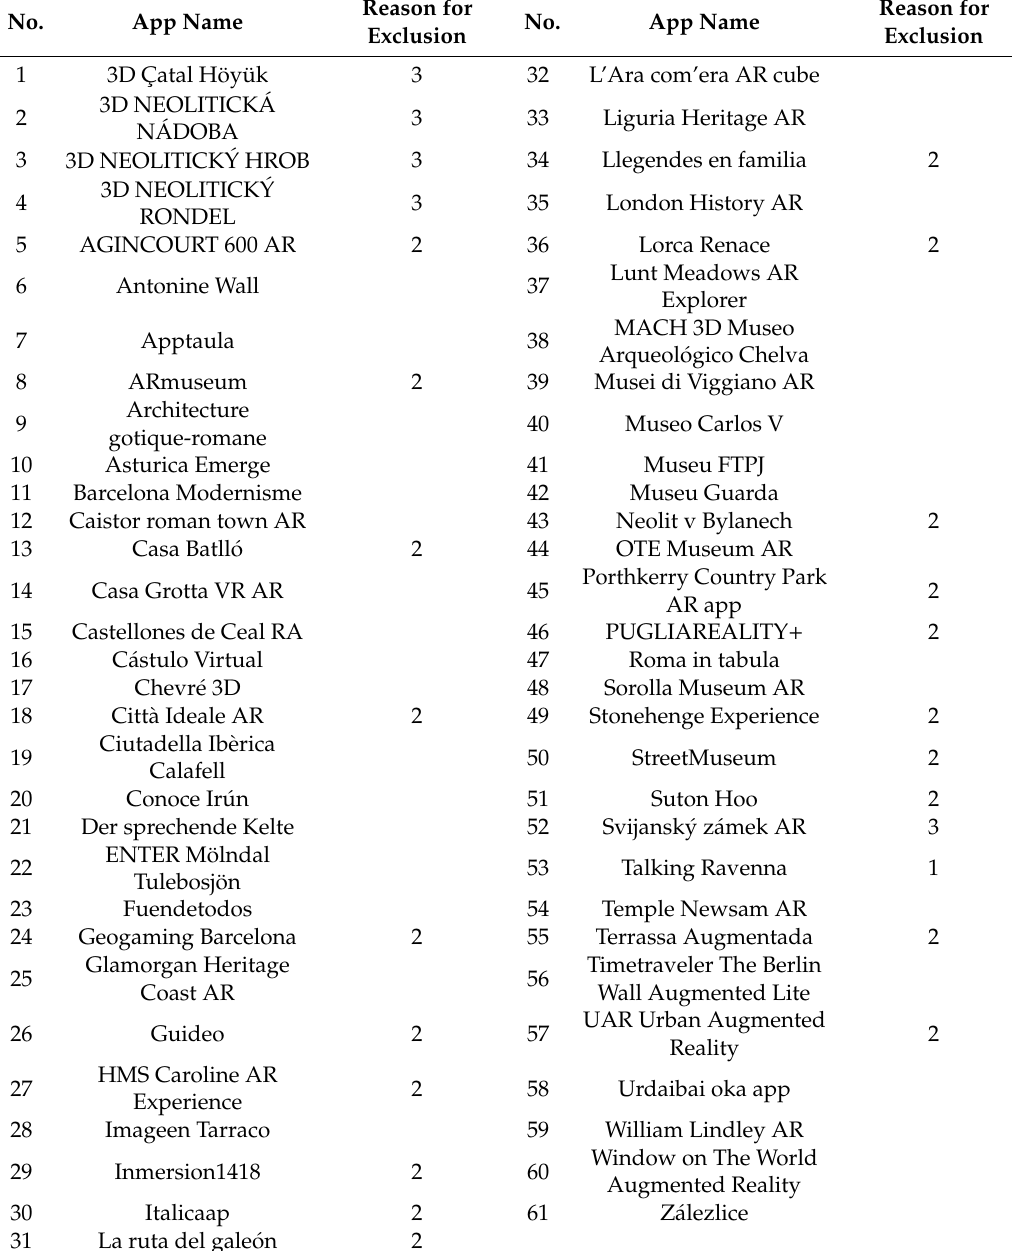
Table 2. Initial sample and reasons for exclusion used to determine the main